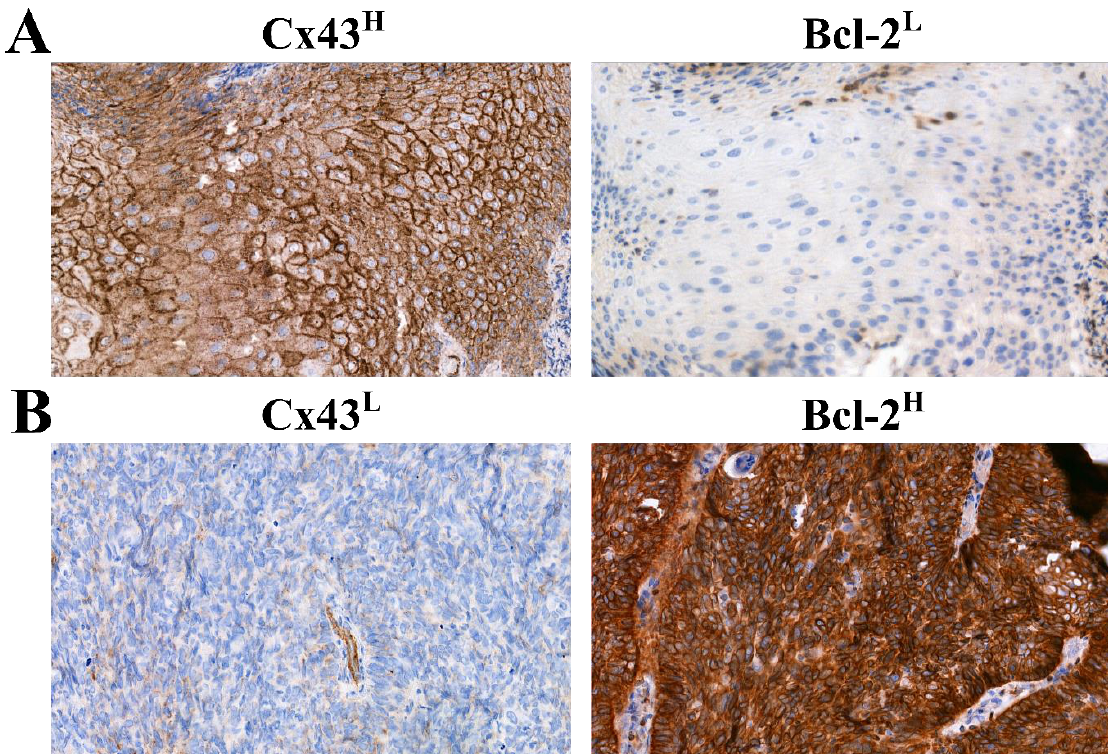
Figure 7. Immunohistochemical analysis of Bcl-2 and Cx43 expression ( A ) Cx43 H / Bcl-2 L ( B ) Cx43 L / Bcl-2 H ) in HNSCC tissue samples. (Magnification: 40×).